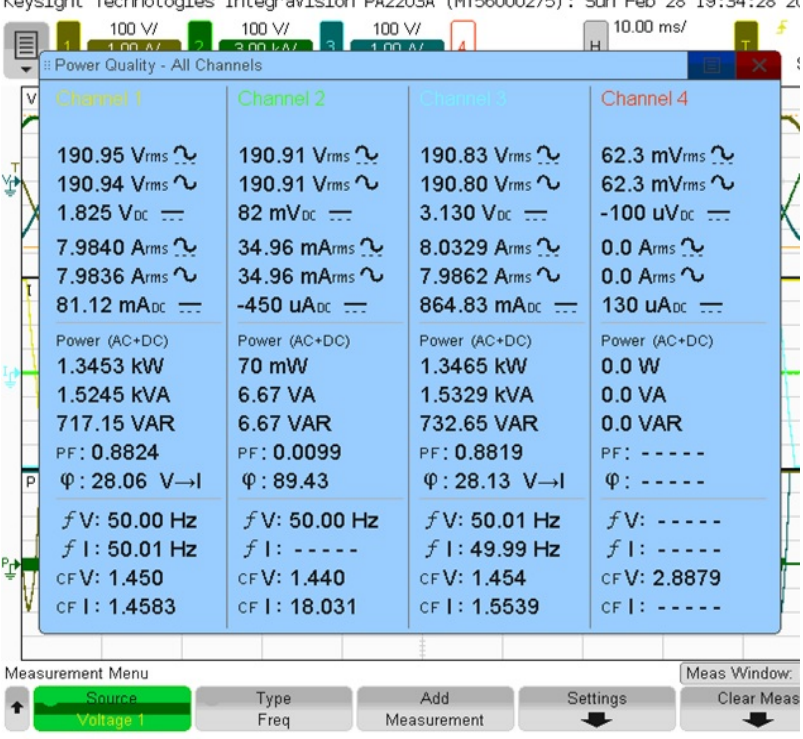
Figure 14. Voltage sag conditions in grid connected to induction motor under loaded conditions.